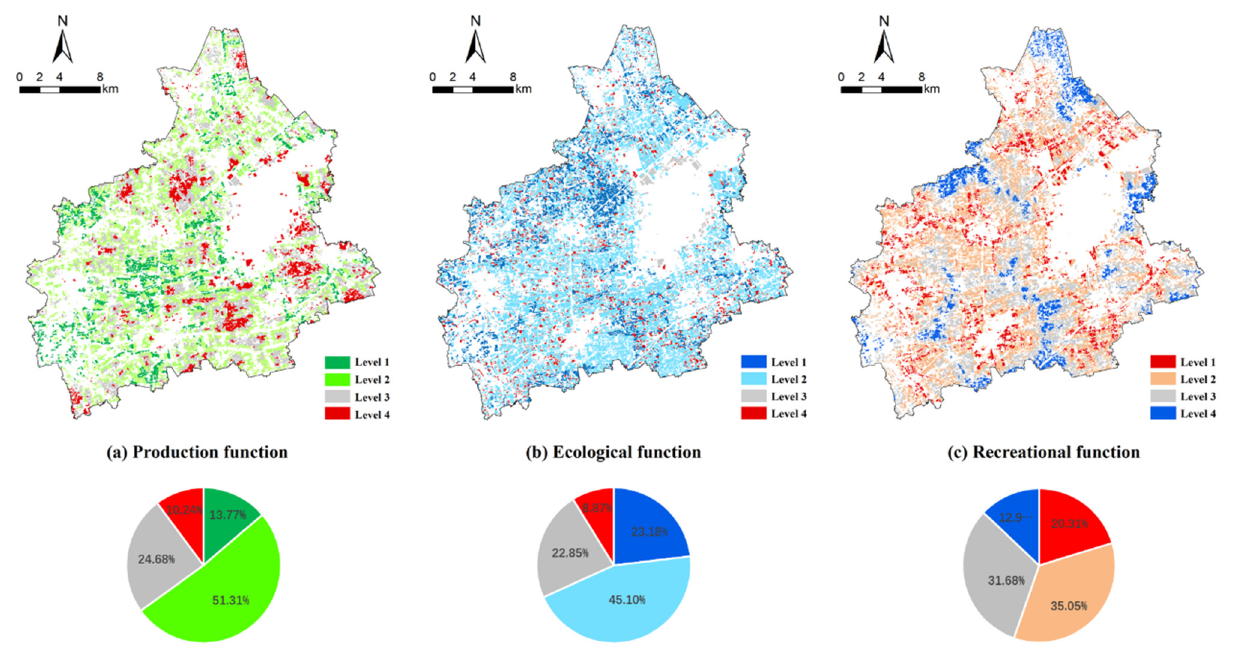
Figure 5. Evaluation of different functions of Tongxiang City; ( a – c ) represent production function, ecological function, and recreational function, respectively.